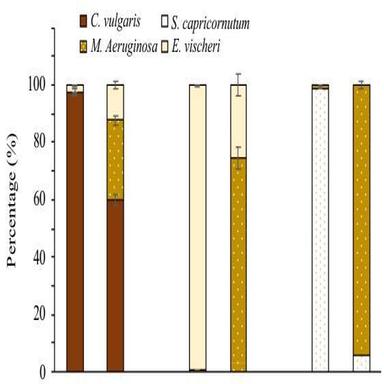
Average values of (a) cell counts and (b) MLSS for different cultures with controlled bacterial addition, and comparison of (c) microalgal population distribution and (d) biomass composition of the mixed cultures with or without controlled bacterial addition after Day 20 (n = 15), with error bars displaying the corresponding standard deviation.